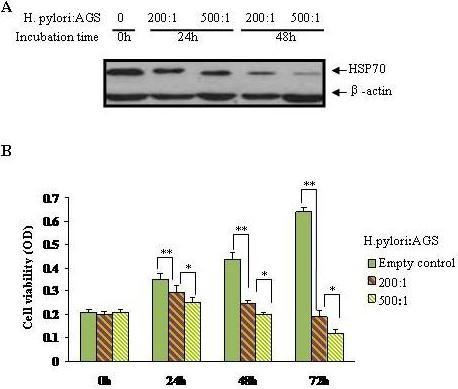
Effects of H. pylori on AGS cells. (A) AGS cells were treated with H. pylori at the ratio of 200:1(bacterium to cells) or 500:1 for 0, 24 or 48 hours, respectively. Suppression of HSP70 in AGS by H. pylori infection was evidenced by immunoblotting. (B) H. pylori infection significantly inhibited cell proliferation in gastric epithelial cell line in a dose- and time-dependent manner. Data are mean ± SD, *P <0.05, **P <0.01.